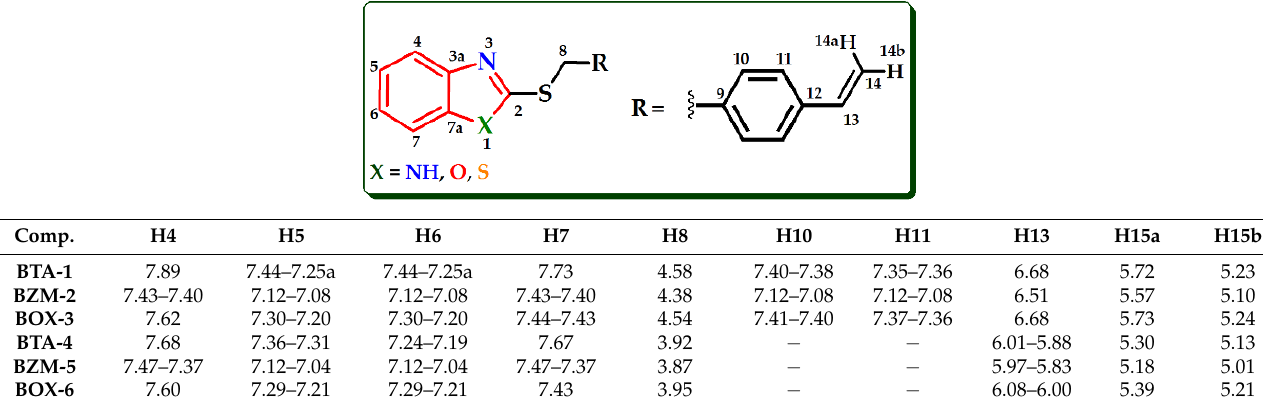
Table 2. 1 H NMR data for 2-substituted benzo [ d ] [1,3] azoles derivatives ( BTA-1 , BZM-2 , BOX-3 , BTA-4 , BZM-5 , and BOX-6